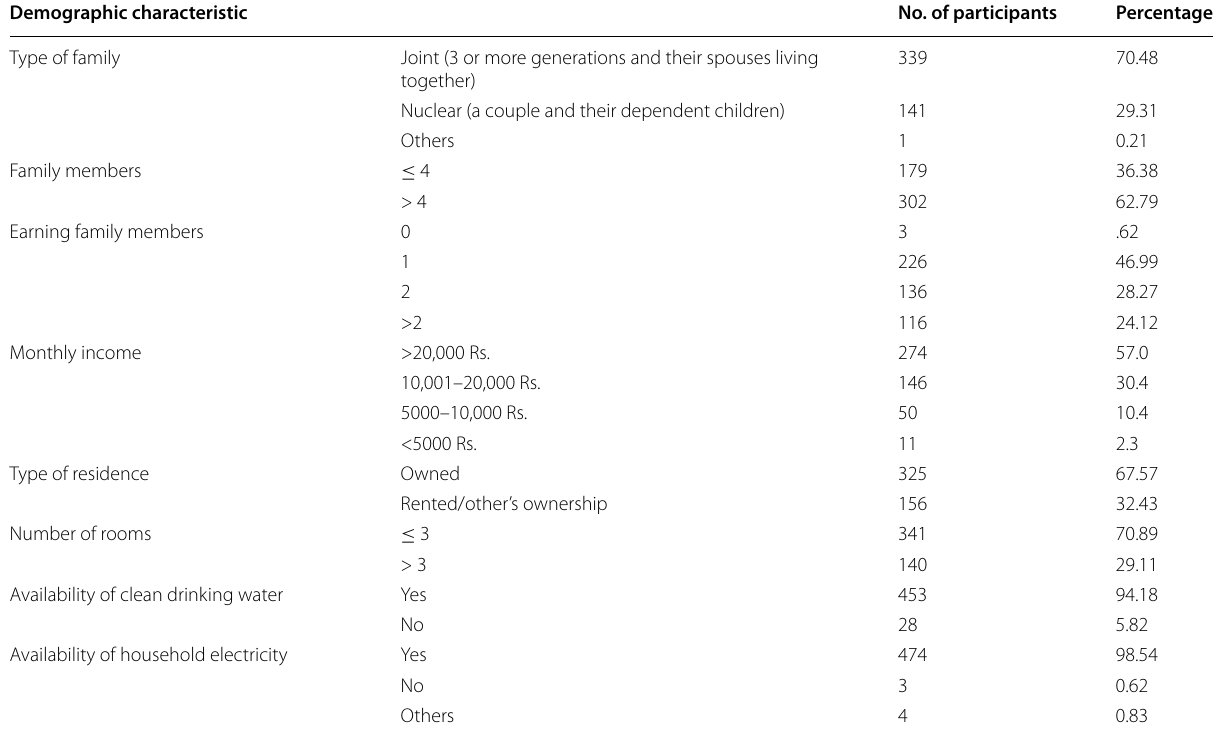
Table 4 Socio-demographic characteristics of families of CP children Demographic characteristic No. of